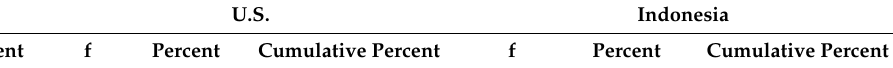
Table 1. Univariate Description of Key Variables for Overall Sample and By Country. Overall